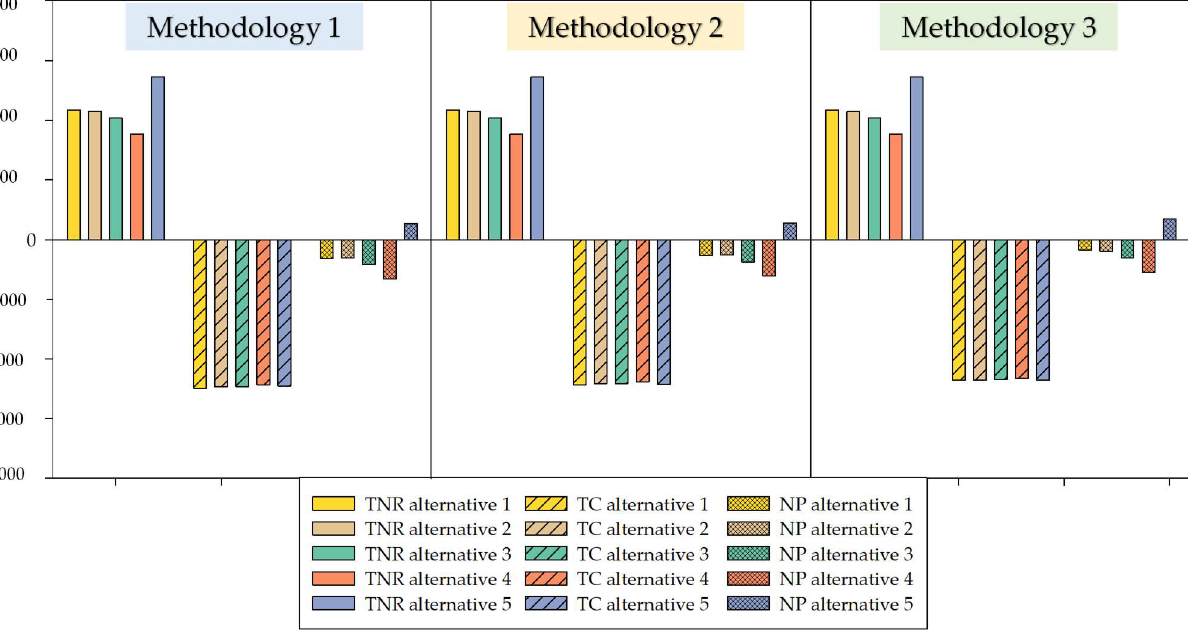
Figure 6. Comparison of the economic performance of the five horticultural alternatives evaluated from February 2016 to January 2021. Methodology 1: conventional; Methodology 2 : self-management of plant debris and reduction in water, soil management, and chemical soil disinfectants; Methodology 3: Methodology 2 + reduction of inorganic fertilization; TNR: total income; TC: total costs; NP: economic benefit. Source: own elaboration based on Torresano and Camacho-Ferre [47], Honore et al. [2], Junta de Andalucia [48], Torres-Nieto [49], and specialized agricultural supply centers.